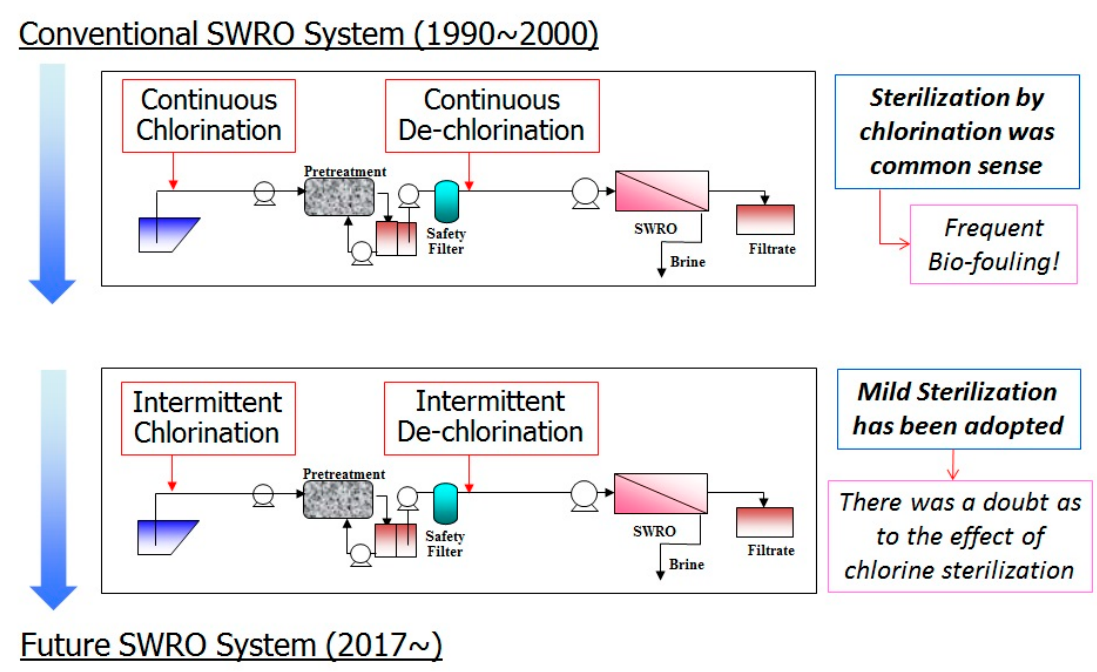
Figure 4. History of anti-biofouling trials for SWRO (Seawater Reverse Osmosis) system